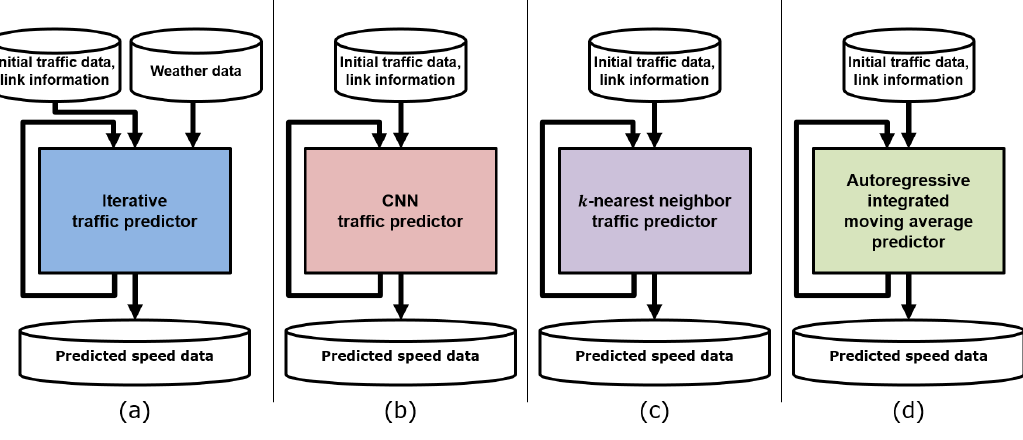
Figure 6. Simplified view of ( a ) TW-DNN, ( b ) CNN-only, ( c ) k -nn, and ( d )